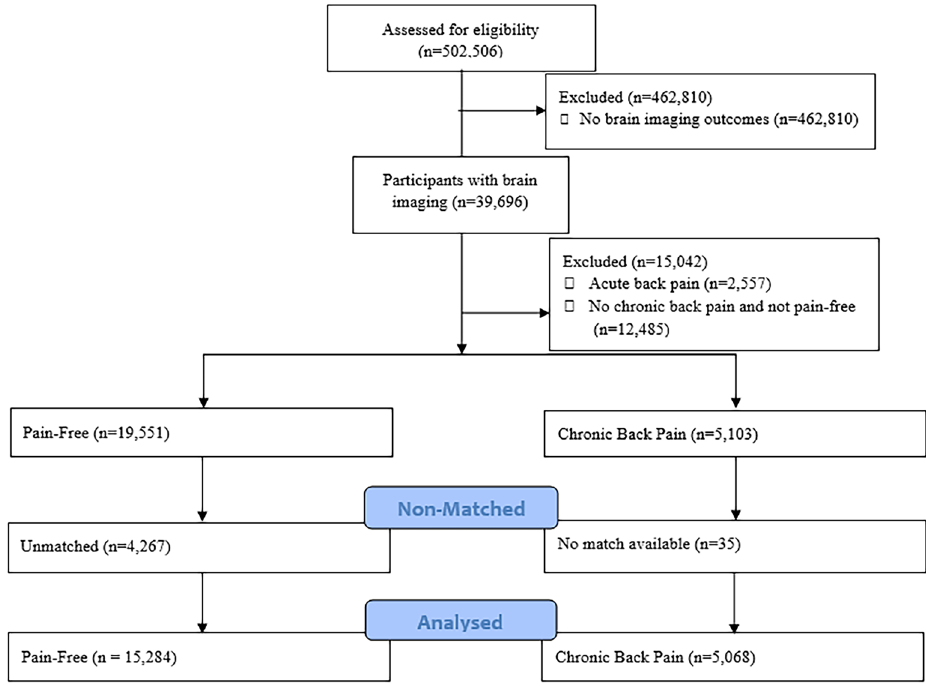
Figure 1. Flow diagram of participant selection for this UKBioBank